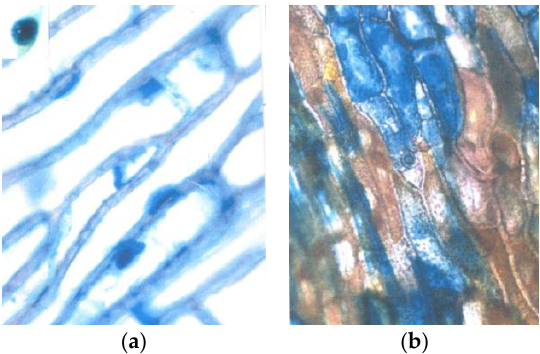
Figure 5. Normal staining of healthy seed wings ( a ) and brown burned seed wings ( b ); blue colors are DMACA treated, cells from a and b have the same size.